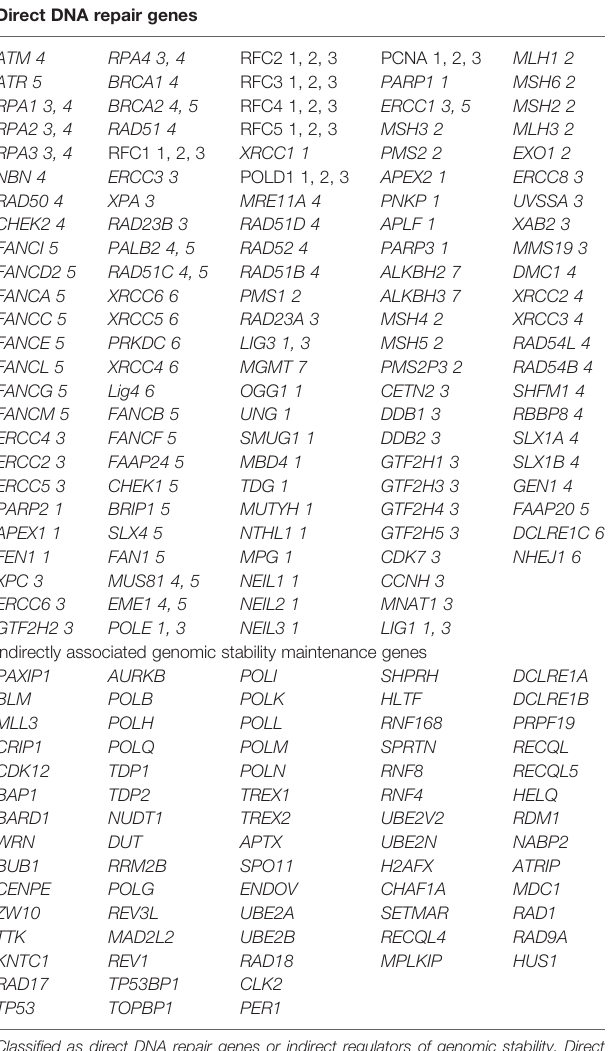
TABLE 1 | List of all 193 DNA repair genes analyzed. Direct DNA repair